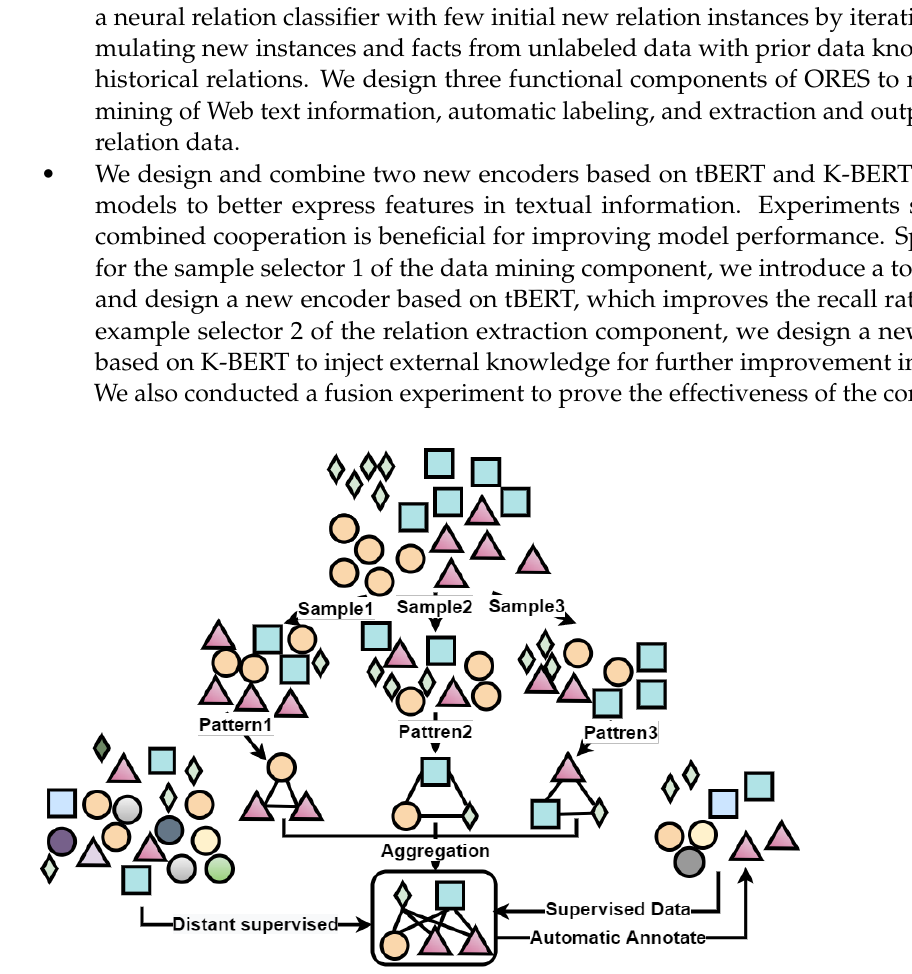
Figure 1. An illustration of how ORES utilizes 3 kinds of data for relation discovery based on distant supervision and